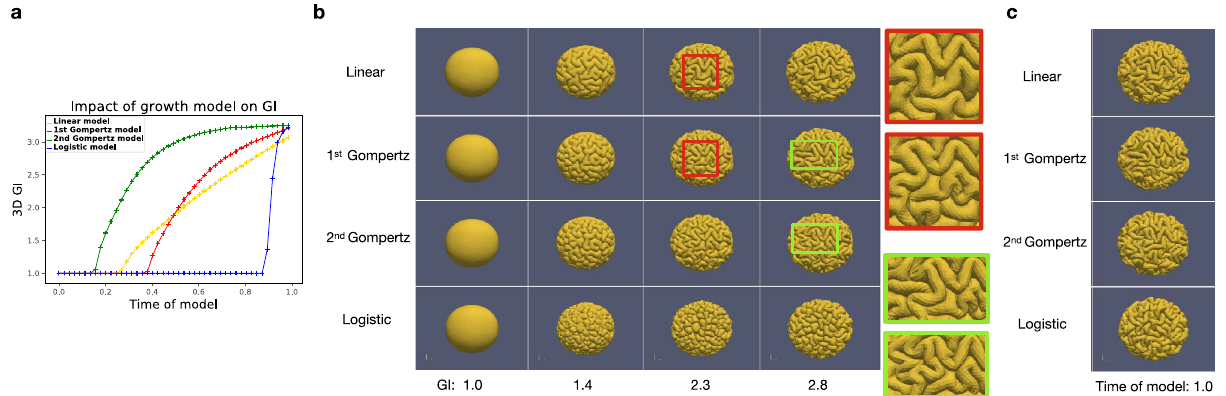
Figure 2. ( a ) The evolution of 3D GI over time for surfaces of different expansion models. ( b ) The comparison of folding patterns on the reference ellipsoid at the same 3D GI based on different expansion models. In red frames: difference in folding patterns for linear and 1st Gompertz models; in green frames: difference in folding patterns for 1st and 2nd Gompertz models. ( c ) The comparison of folding patterns on the reference ellipsoid at